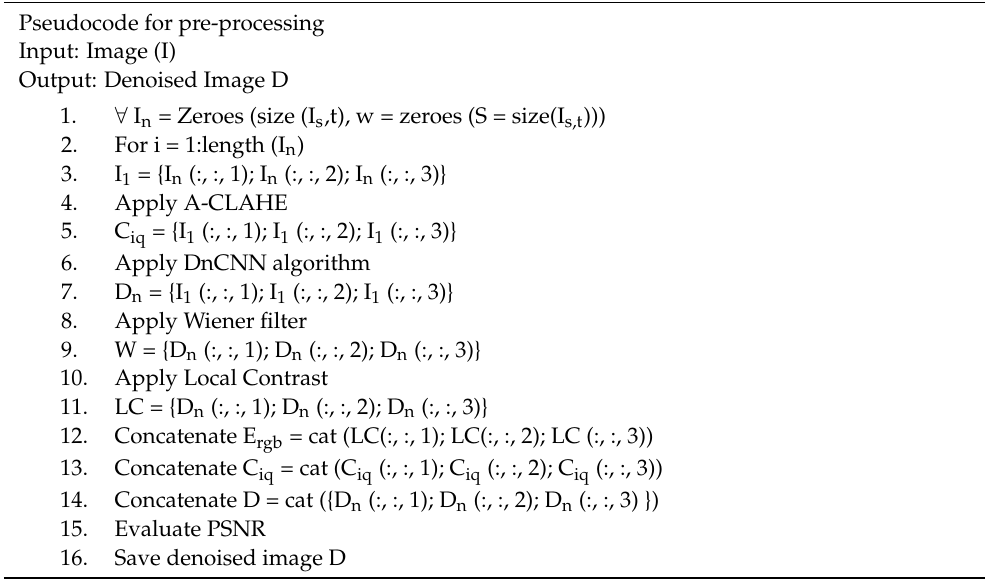
Algorithm 4: Algorithm of Pre-processing of Wiener Filter Pseudocode for